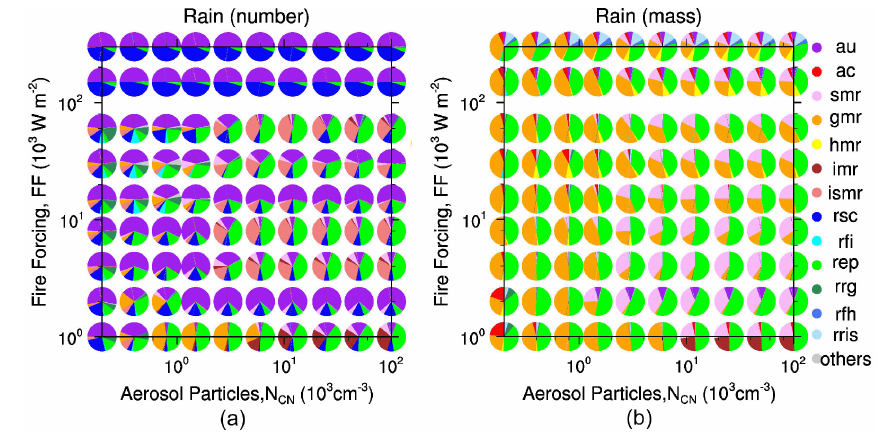
Figure 18. Same as Fig. 16 but for raindrops. Abbreviations are as follows: au, autoconversion; ac, accretion; i/s/g/hmr, melting of ice/snow/graupel/hail to form raindrops; rsc, self-collection of raindrops; ismr, melting of ice and snow to form raindrops; rfi/h, freezing of raindrops to form ice crystals/hail; rep, raindrop evaporation; rrg, riming of raindrops to form graupel; and rris, riming of raindrops to form ice and